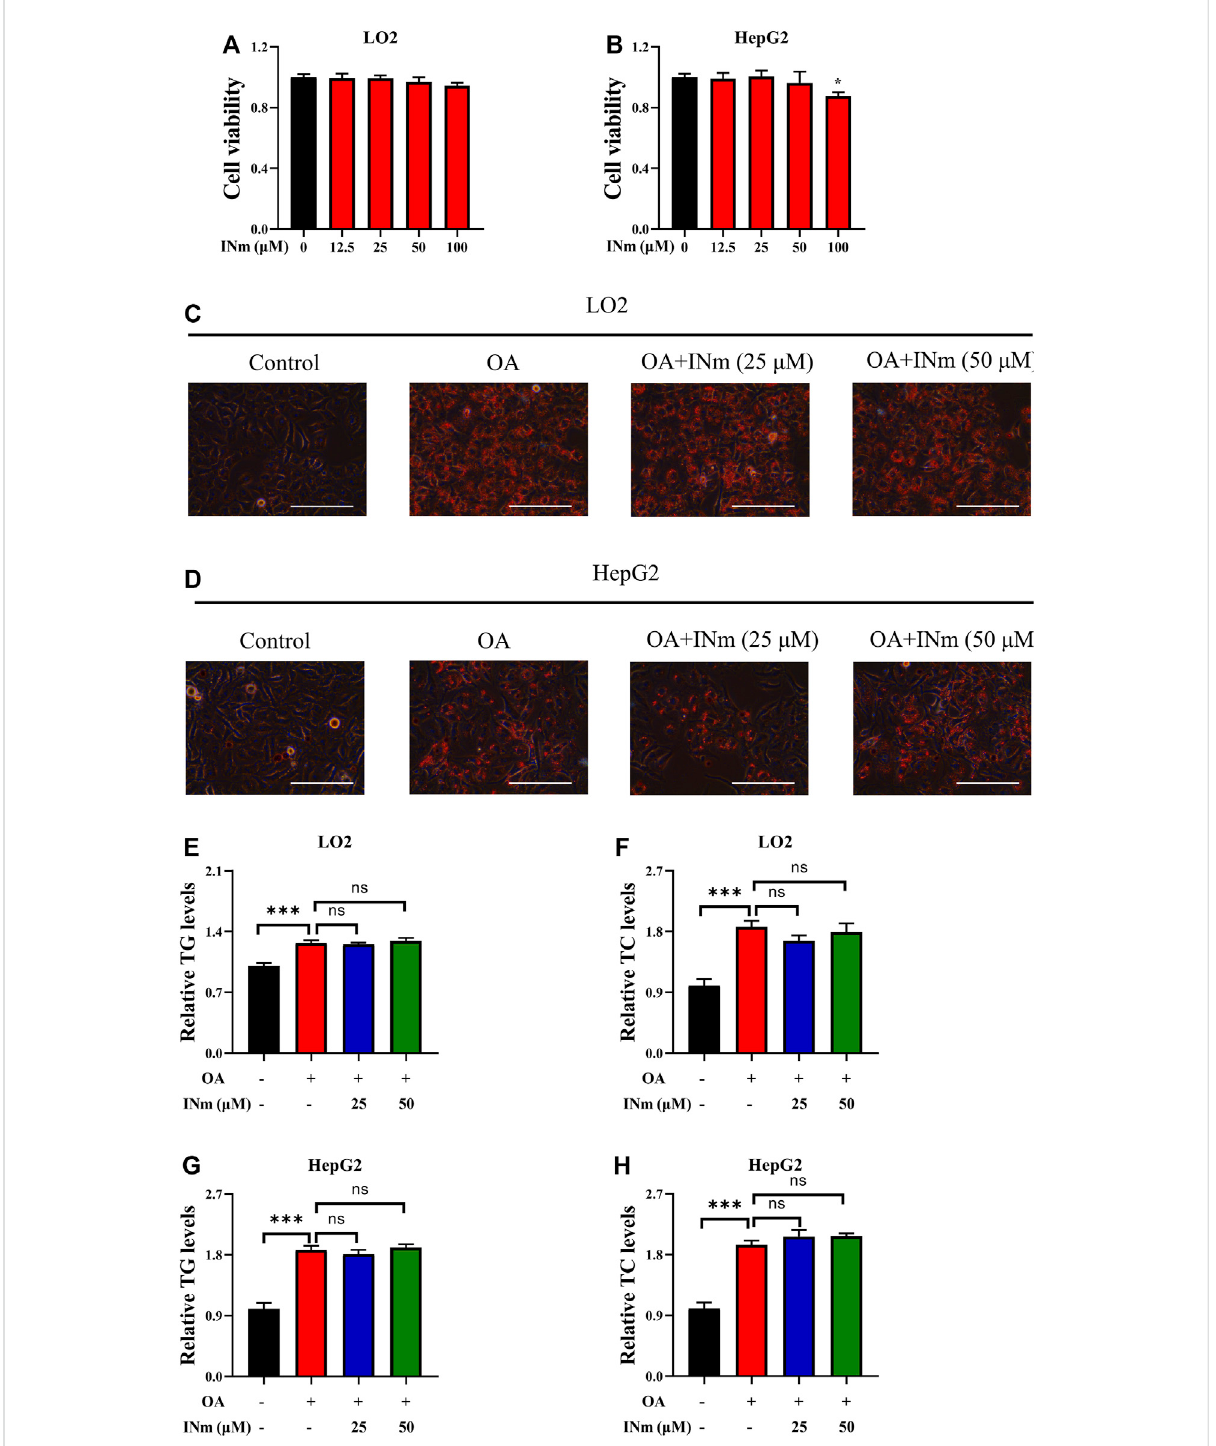
Inhibiting BCATm shows no effect on OA-induced hepatic steatosis. (A,B) LO2 and HepG2 cells were treated with indicated concentrations of BCAT-IN-2 for 48 hand MTTassay wasperformed. (C – H) LO2 and HepG2 cells wereincubatedwith 0.5 mm Oleic acid and 0, 25, 50 µM BCAT-IN- 2 for 48 h. Intracellular lipid droplets were detected by Oil red O staining. Scale bar = 400 μ M (C,D) . Intracellular TC and TG levels in LO2 (E,F) and HepG2 (G – H) cells weredetected. Data are shown as the mean± SD of three independent experiments.*** p < 0.001, ns p > 0.05. INm: BCAT-